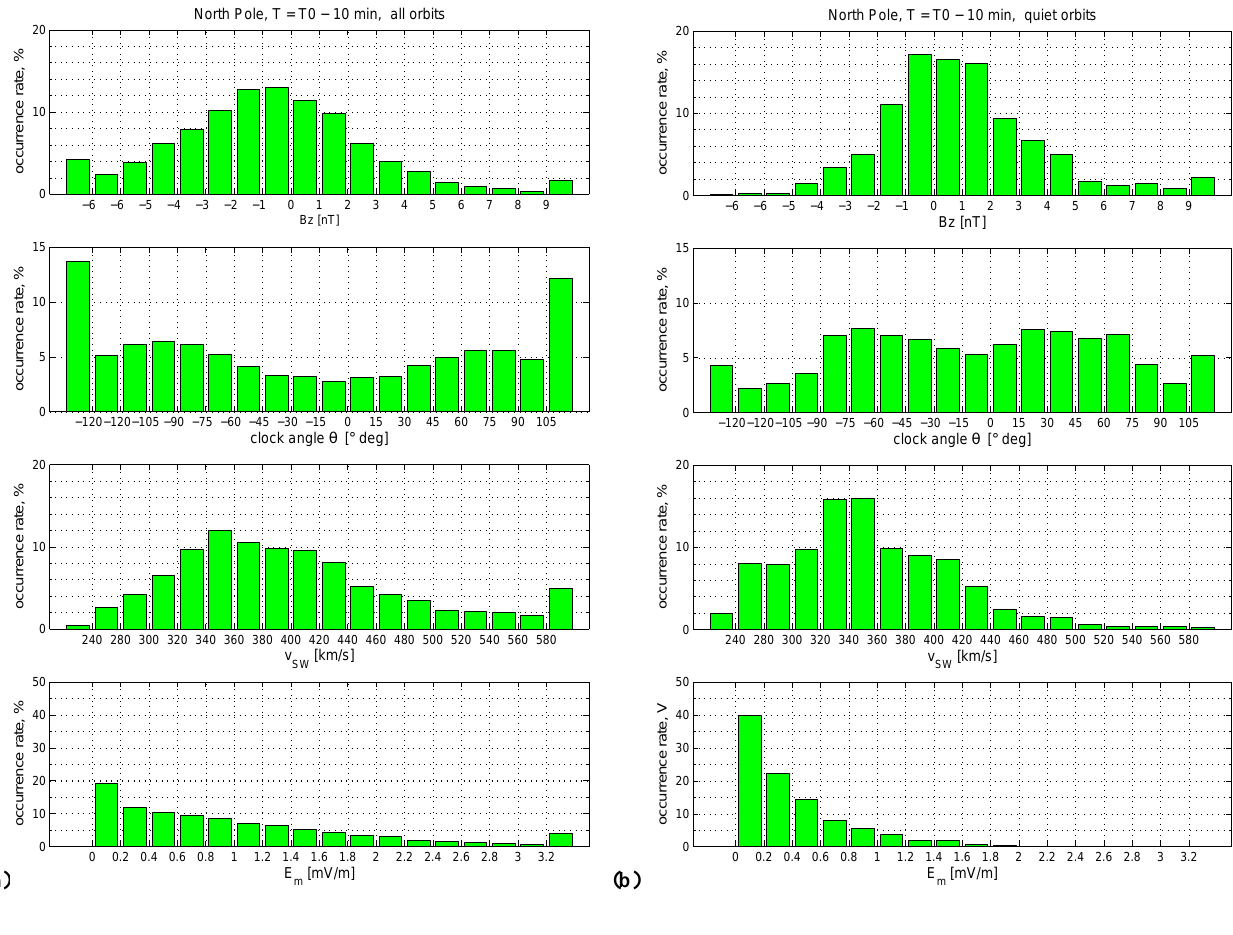
Fig. 9. Occurrence rates of the IMF B z , the IMF clock angle θ = atan(B y /B z ) , the solar wind velocity v SW , and the merging electric field E m for all orbits (left) and for the quiet orbits (right), taken at a time t=10min before the key time. The bars at the left and right ends of the panels include all events occurring beyond the labelled parameter